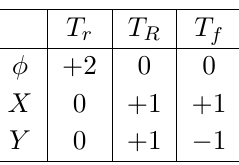
Table 1 . Charges of the complex scalars in the the Cartan generators of the R-symmetry u (1) r